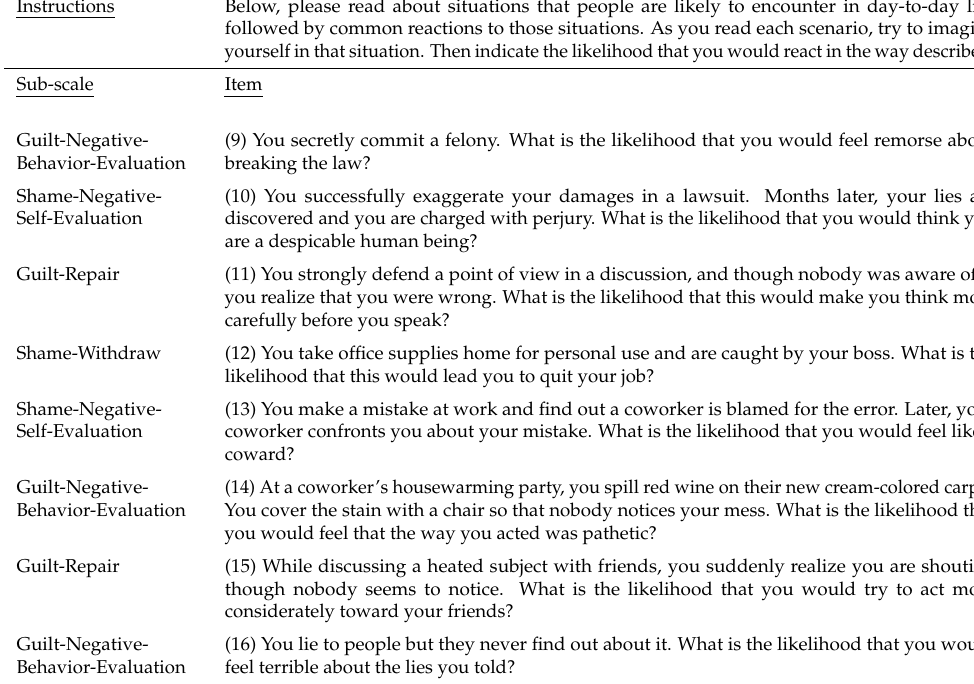
Table A2. Guilt and Shame Proneness Scale: